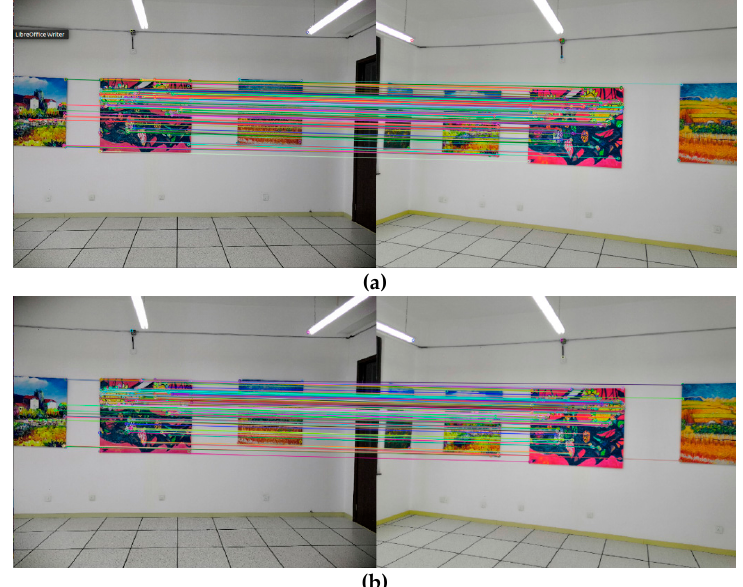
Figure 12. Matching optimization results of different algorithms: (a) RANSAC and (b) PROSAC.